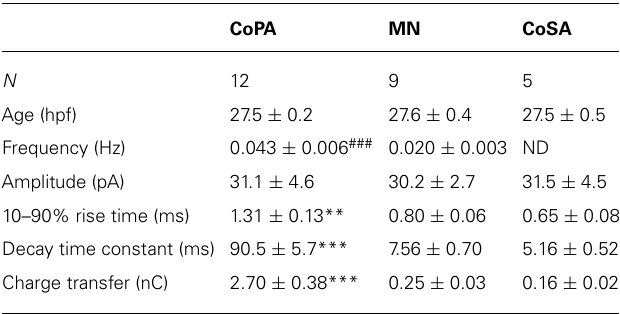
Table 2 | Properties ofAMPAergic mPSCs in CoPA interneurons from 26 to 29 hpf